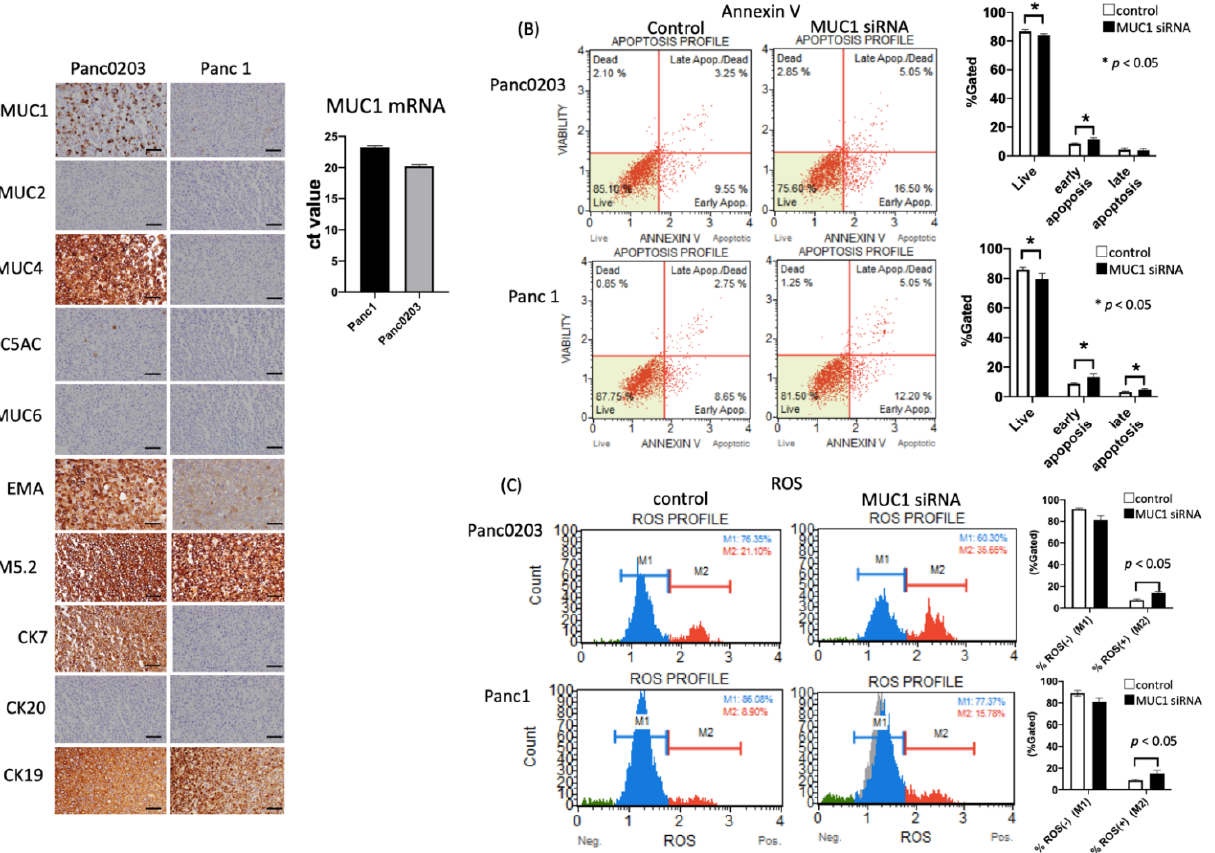
Figure 2. Characterization and function analysis under MUC1 suppression in Panc0203 and Panc1. ( A ) ( Left ) Immunocytochemical staining of various epithelial markers. Panc0203 and Panc1 cell blocks were prepared and immunohistochemically stained. ( × 100; scale bar; 100 µ m) ( Right ) Evaluation of Ct value of MUC1 mRNA by quantitative RT-PCR method. ( B ) Annexin V analysis for the detection of apoptosis in Panc0203 and Panc1 cells, (* p < 0.05). ( C ) Dynamics of reactive oxygen species in Panc0203 and Panc1 transfected with MUC1 siRNA. Left panel: Blue peaks indicate ROS negative (M1 peak) and red peaks indicate ROS positive (M2 peak). Gray shadows indicate negative